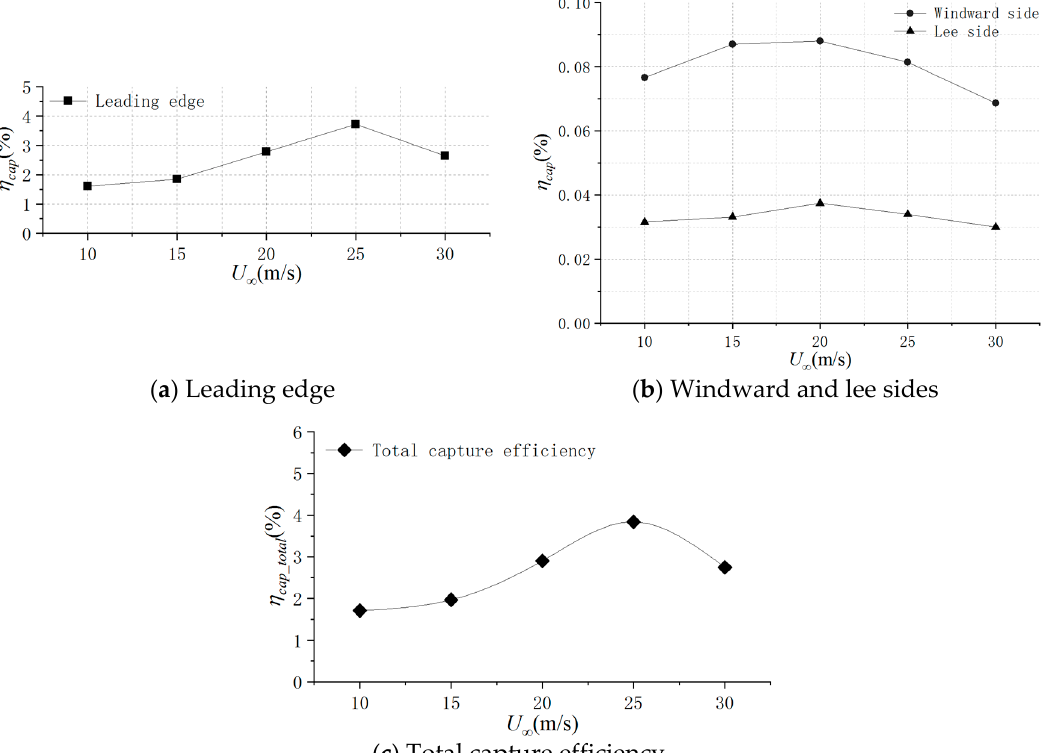
Figure 12. Capture efficiency at different mainstream velocities.